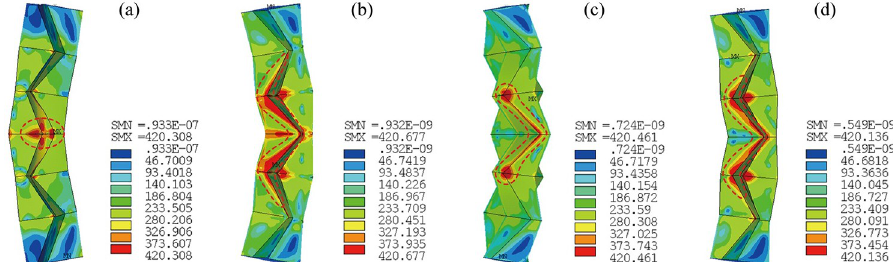
Fig 11. Deformation and stress distribution of tubes at Δ = 60 mm. (a) C-ORI-1; (b) C-ORI-2; (c) C-ORI-3; (d) C-ORI-4.